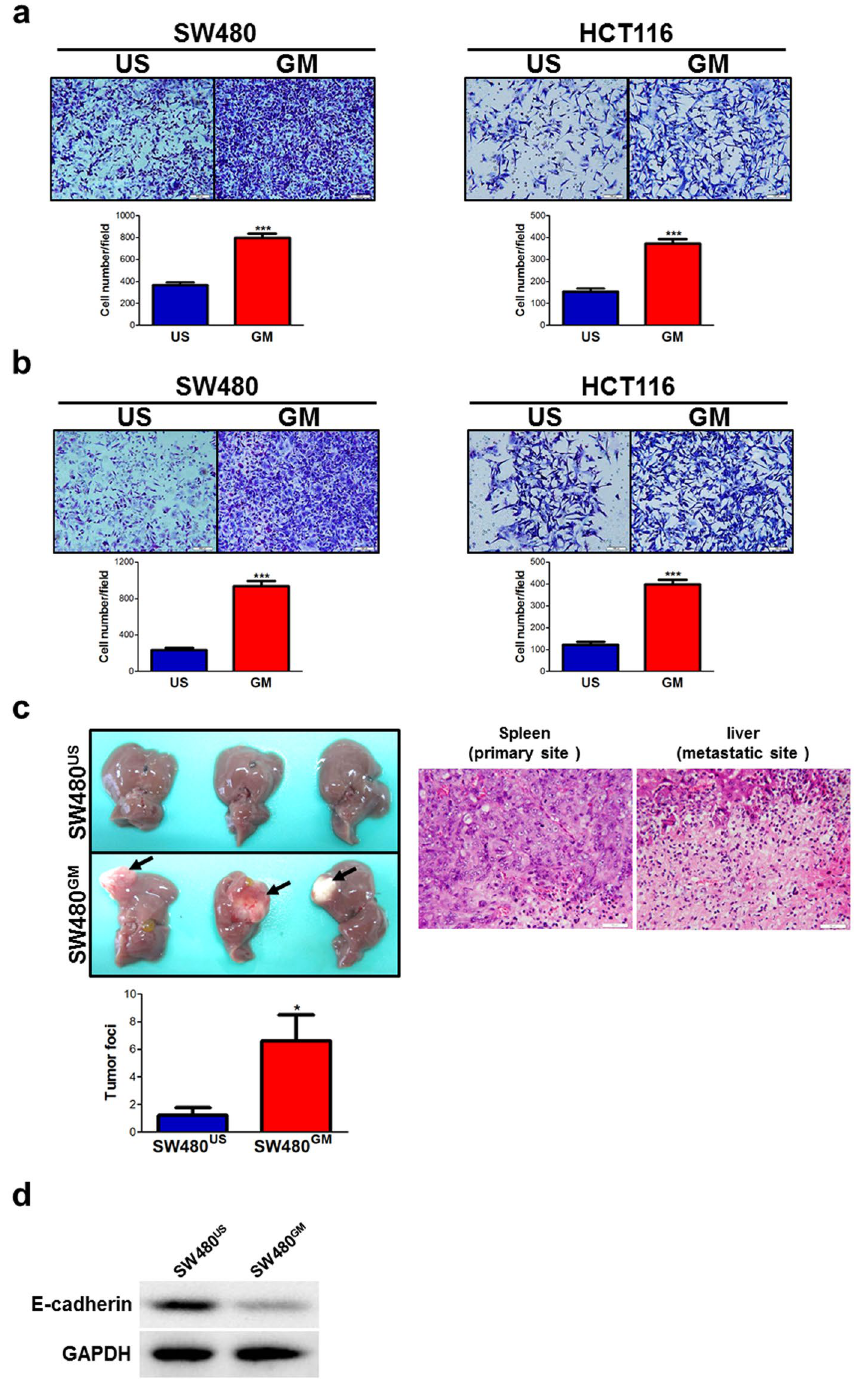
Figure 2. GM-CSF-exposed colon cancer cells exhibit augmented motility in vitro and in vivo . ( a , b ) SW480 and HCT116 colon cancer cell lines were treated with GM-CSF (25 ng/ml) for three weeks. The ability of migration ( a ) and invasion ( b ) was examined by transwell experiments. Upper: representative images were shown. Bottom: the data were pooled from three experiments. ( c ) SW480 cell lines were treated with GM- CSF as described above and collected as well as transfused to nude mice in a model of colorectal cancer liver metastasis as described in Materials and methods. Four-to-six weeks later, livers were pooled and tumor foci per mouse were calculated. Left panel: Representative macroscopic images were shown. The arrows denoted metastatic lesions. Right panel: Representative microscopic images of primary (spleen) and metastatic (liver) tumor sites were shown. Scale bar: 50 μ m. The data were pooled from three experiments. ( d ) Tumors in spleen of recipients were collected and E-cadherin expression was detected by immunoblotting. Cropped blots were shown. * P < 0.05; ** P < 0.01; *** P < 0.001 vs untreated